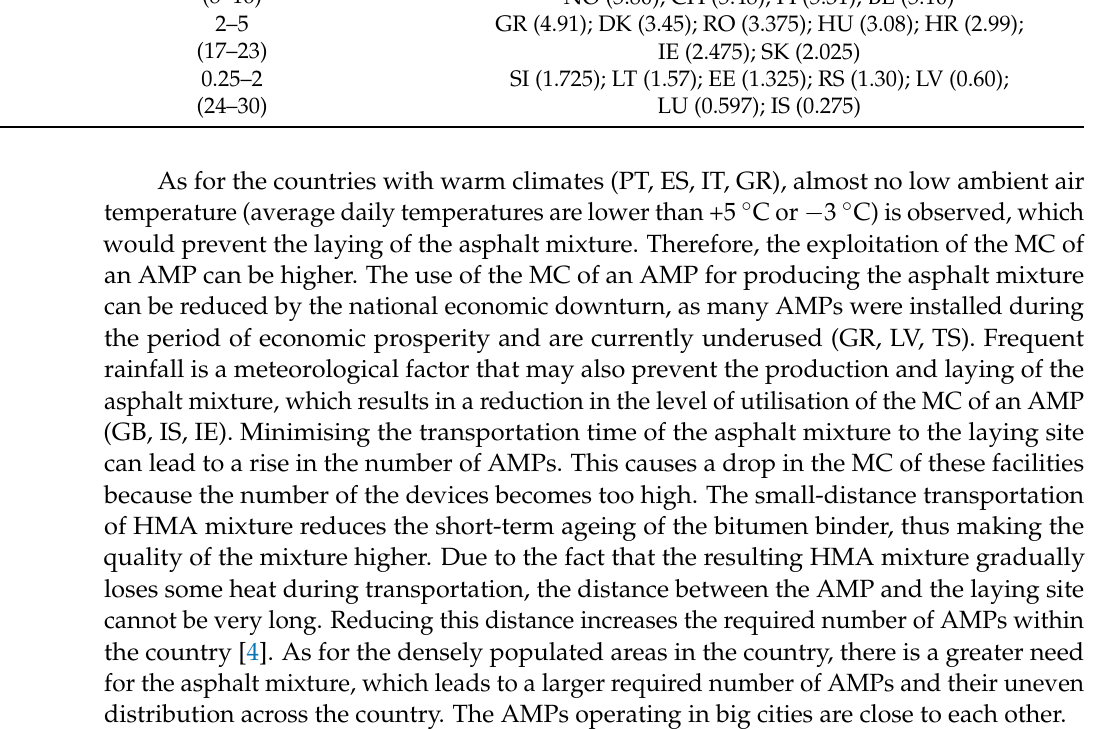
Table 1. The categorization of the countries according to the amount of asphalt mixture produced. The National Abbreviation and the Actual Average The Amount of the Asphalt Mixture The Scale of the Amount of the Mixture Produced in all the AMPs in Millions of Tonnes and the Rank Amount (Mass) (Millions of Tonnes/Year) of the Quantity 30–50 Very large Large